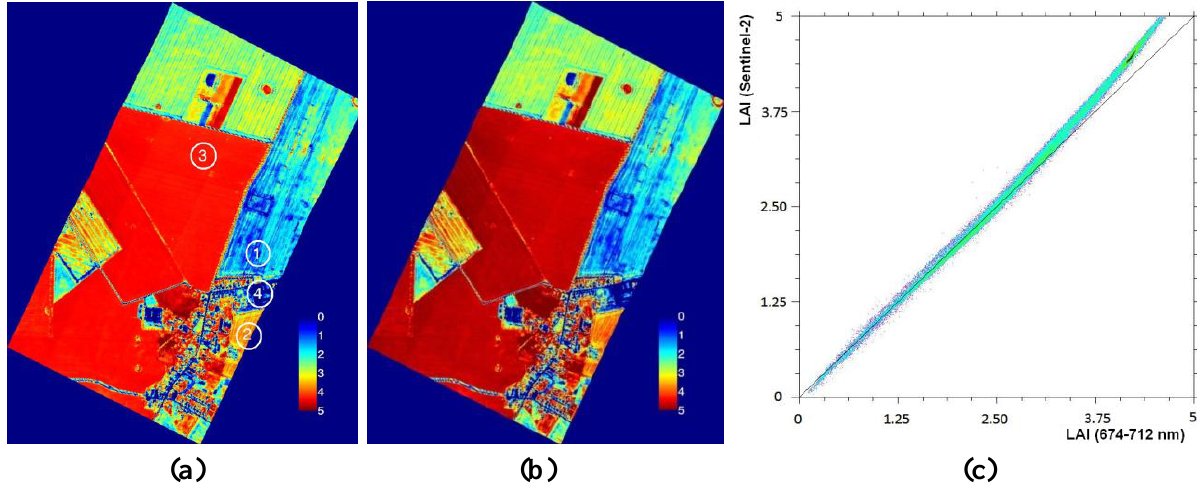
Figure 2. (a) Green LAI map derived from CASI data using NDI on bands at 674 and 712 nm; (b) Green LAI map from S2 bands B4 and B5. Numbers on the 2a map indicate the locations used for validation; (c) Scatter plot of the LAI maps derived from CASI and S2 data using NDI.